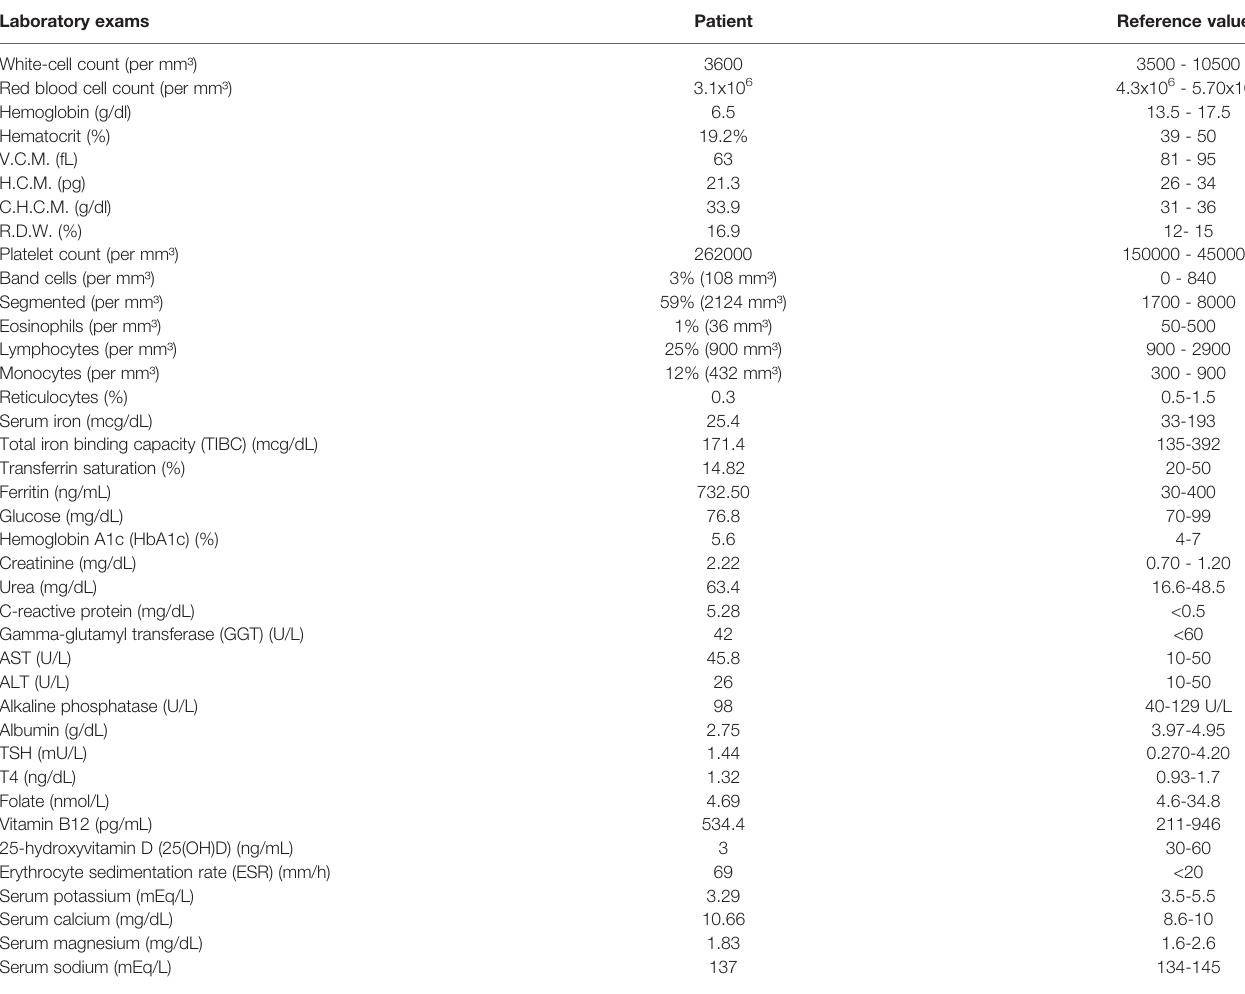
TABLE 1 | Laboratory